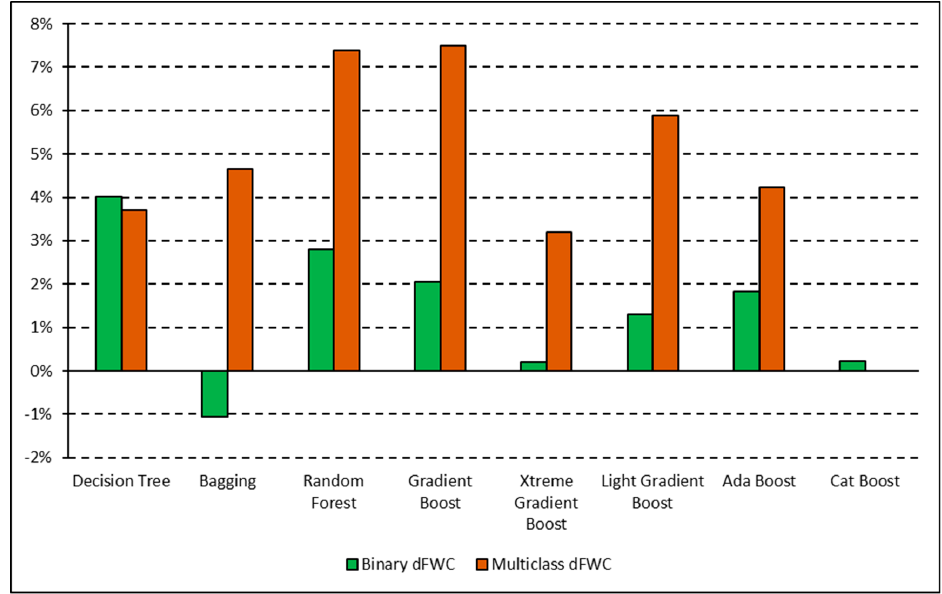
Figure 4. XGB had the lowest dFWC for both binary and multiclass schemes (0.2%, 3.19%, respec- tively). Cat Boost also had dFWC of 0.2% for binary. Decision Tree performed worst overall when considering both schemes, with binary dFWC of 4.01% and multiclass dFWC of 3.7%.